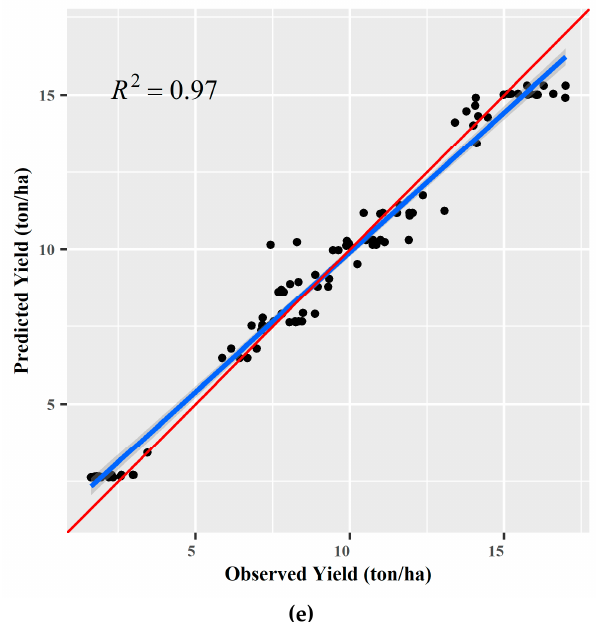
Figure 12. Scatter plot of observed versus predicted yield model of corn using gradient boosting machines: ( a ) V3; ( b ) V4-5; ( c ) V6-7; ( d ) V10; ( e ) VT stages.